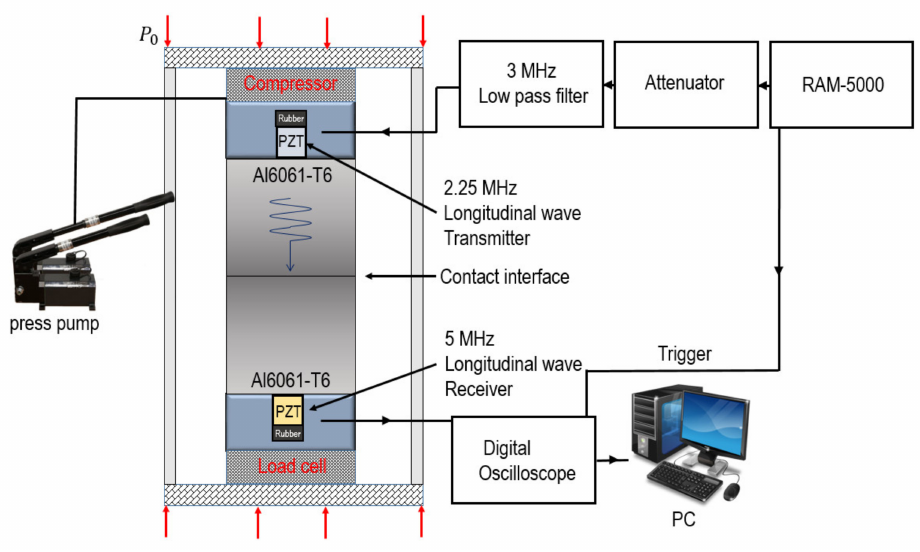
Figure 8. Experimental